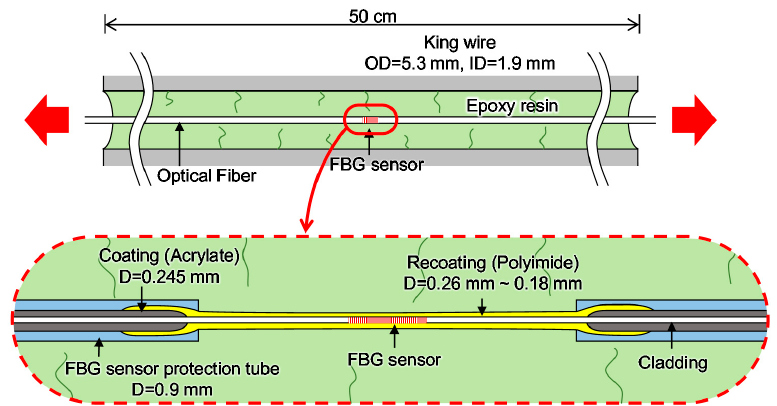
Figure 10. Schematic diagram of the king wire of the smart strand embedding the FBG sensor subject to a tensile load.